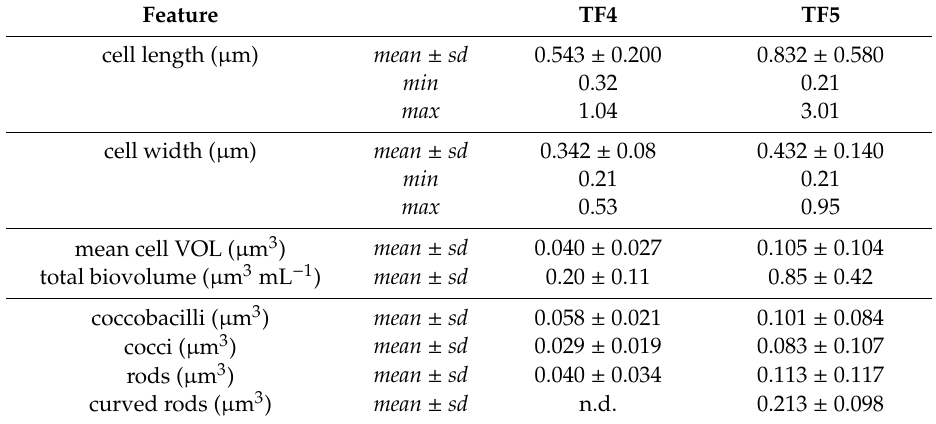
Table 1. Morphometrical and morphological features of the prokaryotic cells in the brines TF4 and TF5. Feature TF4 TF5 cell length ( µ m) mean ± sd 0.543 ± 0.200 0.832 ± 0.580 min 0.32 0.21 max 1.04 3.01 cell width ( µ m) mean ± sd 0.342 ± 0.08 0.432 ± 0.140 min 0.21 0.21 max 0.53 0.95 mean cell VOL ( µ m 3 ) mean ± sd 0.040 ± 0.027 0.105 ± 0.104 total biovolume ( µ m 3 mL − 1 ) mean ± sd 0.20 ± 0.11 0.85 ± 0.42 coccobacilli ( µ m 3 ) mean ± sd 0.058 ± 0.021 0.101 ± 0.084 cocci ( µ m 3 ) mean ± sd 0.029 ± 0.019 0.083 ± 0.107 rods ( µ m 3 ) mean ± sd 0.040 ± 0.034 0.113 ± 0.117 curved rods ( µ m 3 ) mean ± sd n.d. 0.213 ±